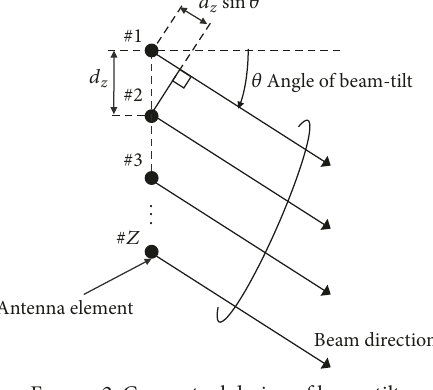
Figure 2: Conceptual design of